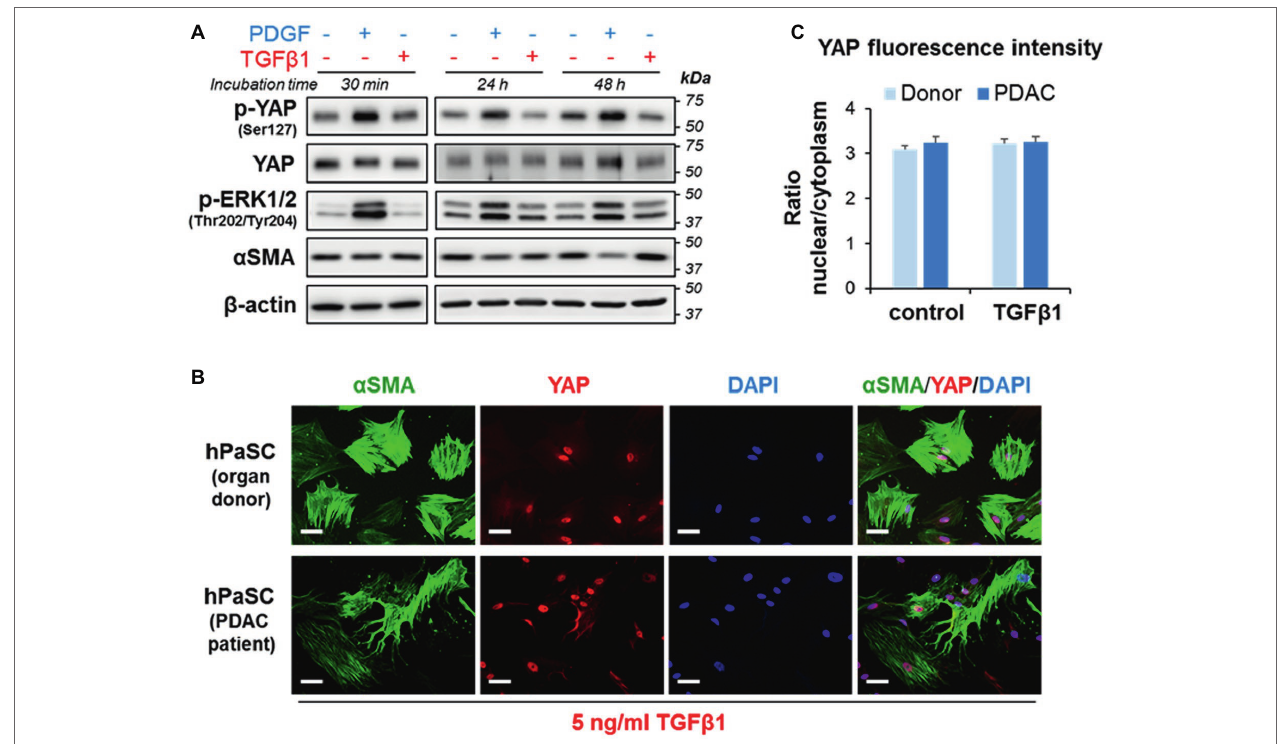
FIGURE 7 | TGF β 1 does not affect does not affect YAP phosphorylation at Ser127 or YAP cellular localization in PaSC. (A) imPaSC were cultured in DMEM containing 10% FBS, starved in serum-free media for 12 h before experiment and then left untreated or treated with PDGF (2 ng/ml) or TGF β 1 (5 ng/ml). Immunoblots show protein levels of the indicated targets; β -actin was used as loading control. As shown in the pictures, PDGF induced sustained YAP phosphorylation at Ser127, whereas TGF β 1 had no effect. Similar results were found in primary PaSC obtained from mouse or human tissues (not shown). (B) hPaSC isolated from cadaveric pancreata (organ donors) or pancreatic tumor surgical resections (PDAC patients; see Figure 2D ) were expanded in culture using DMEM/F12 medium containing 10% FBS until 70–90% confluency (as in Figure 2D ) and then treated with 5 ng/ml TGF β 1 for 60 min. As observed in untreated cells ( Figure 2D ), YAP immunofluorescence was also mainly restricted to the nucleus in TGF β 1-treated cells. Data are representative of three independent experiments. Scale bar, 50 μ m. (C) Graph shows relative YAP localization in untreated and TGF β -treated cells obtained from donors or PDAC patients. Cellular YAP fluorescence is expressed as the nuclear/cytoplasmic ratio (mean ± SEM, n = 70–90 cells). As shown in the graph, TGF β 1 treatment had little effect on cellular localization of